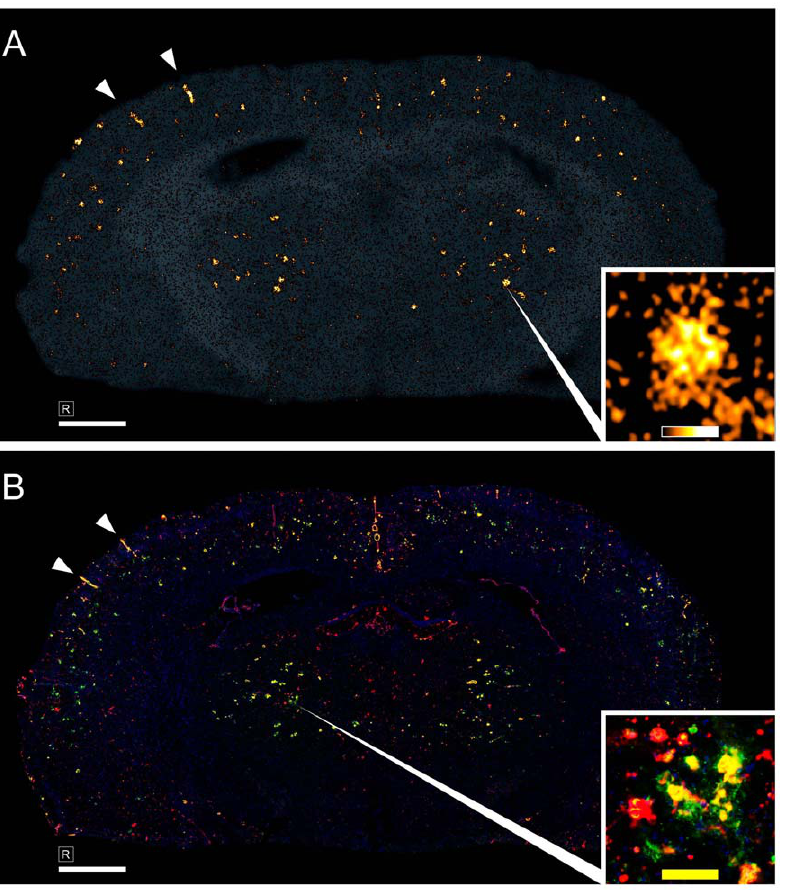
Figure 4. In vivo binding of [ 3 H]PIB to amyloid plaques. A , Ex vivo digital autoradiography co-registered to its optical scan of a coronal brain section at about 2 0.94 Bregma of a 17 months old hemizygous female ARTE10 mouse killed 40 min after intravenous administration of [ 3 H]PIB. The dotted pattern demonstrates uptake of tracer in A b aggregates of cortical and thalamic regions. B , Immunofluorescence stain for A b 40 ( green ), A b 42 ( red ) and nuclei ( blue ) of a close parallel section. Insets: single plaque taken from marked positions. Arrowheads: Tracer binding and A b staining of amyloid- b in vessels. Scale bars in overview: 1 mm. Color and scale bars in insets: 100 m m